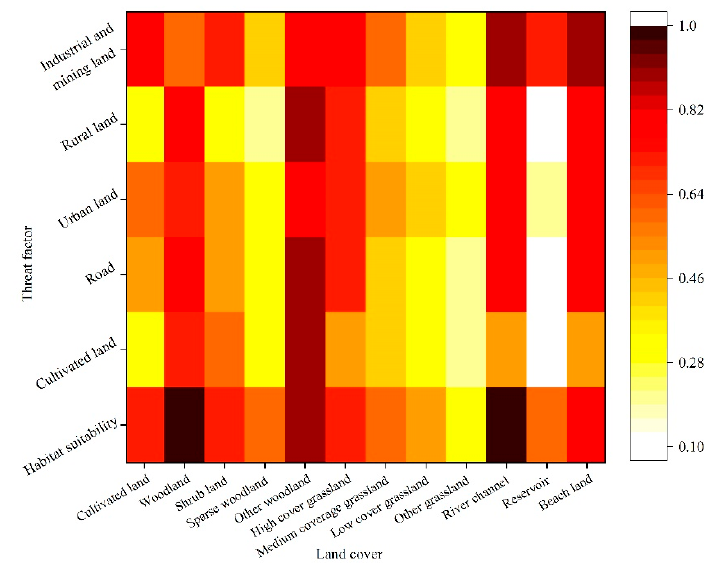
Figure 5. Sensitivity of land covers to habitat threat